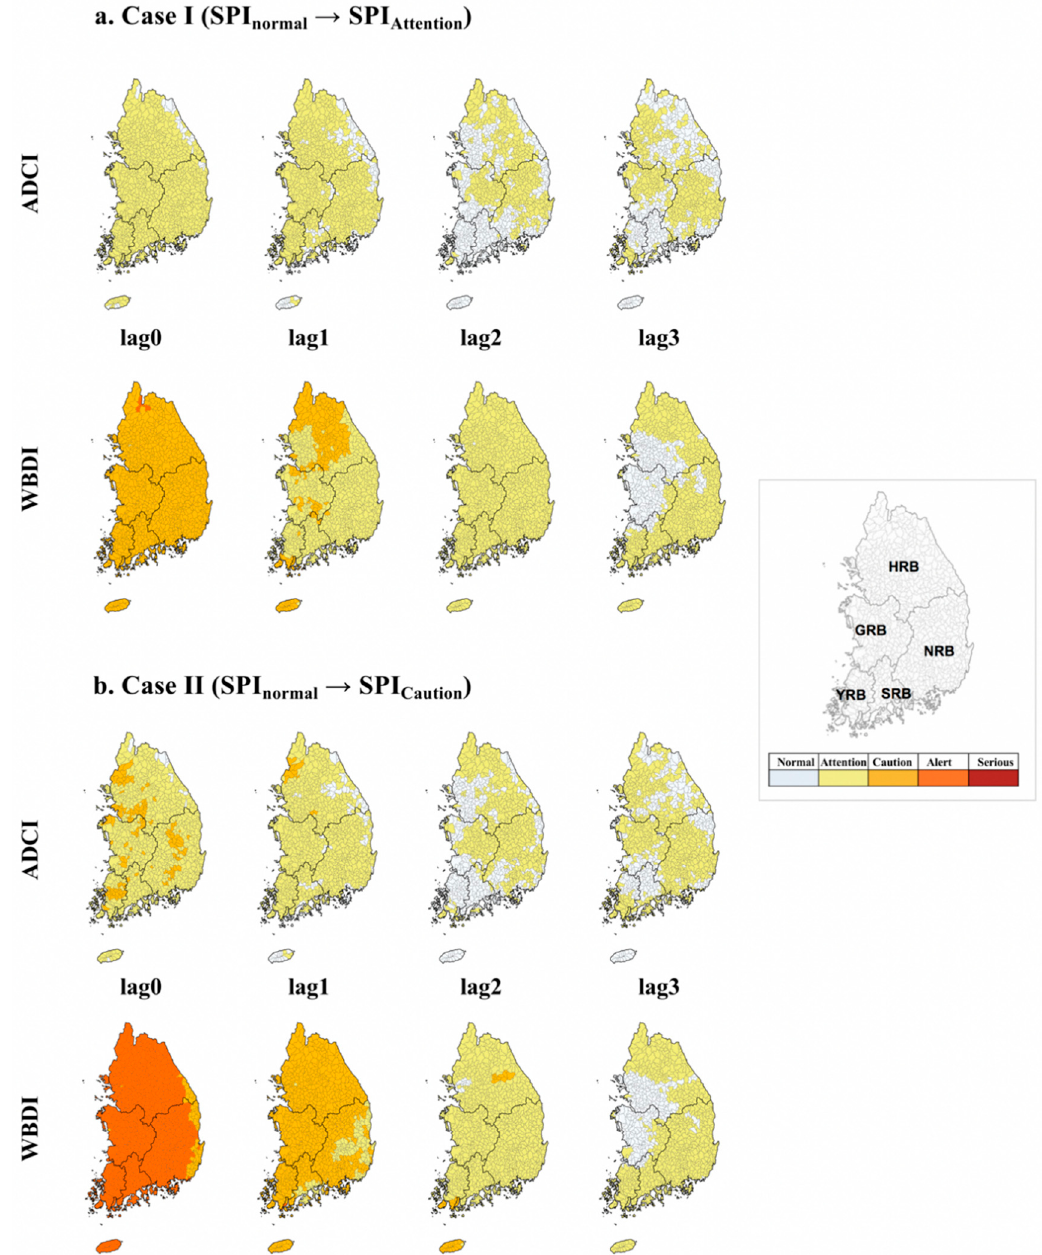
Figure 10. Drought condition changes in IBB simulation of ADCI and WBDI. ( a ) Case I (SPI normal → SPI Attention ) and ( b ) Case II (SPI normal → SPI Caution ). The simulation results for the five basin areas for up to three months are colored in the map.